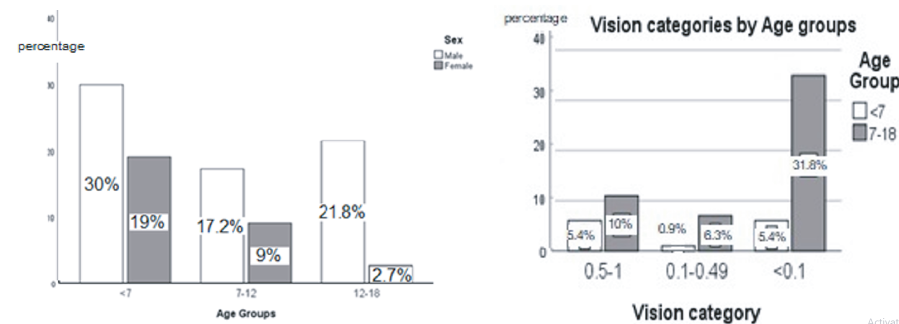
Figure 2. Vision categories by sex and age groups.